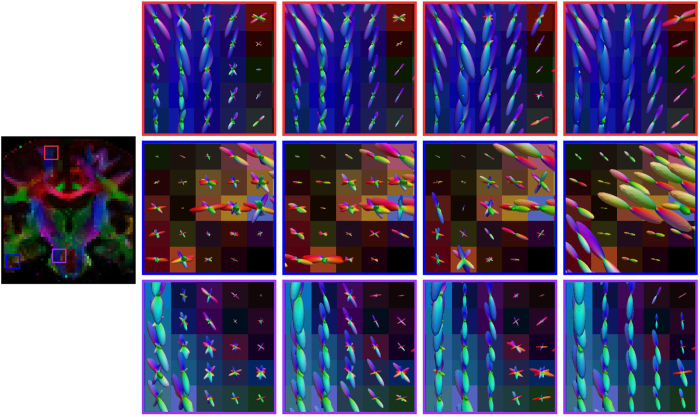
Coronal view of ODFs.Similar to Fig. 6, but in coronal view.